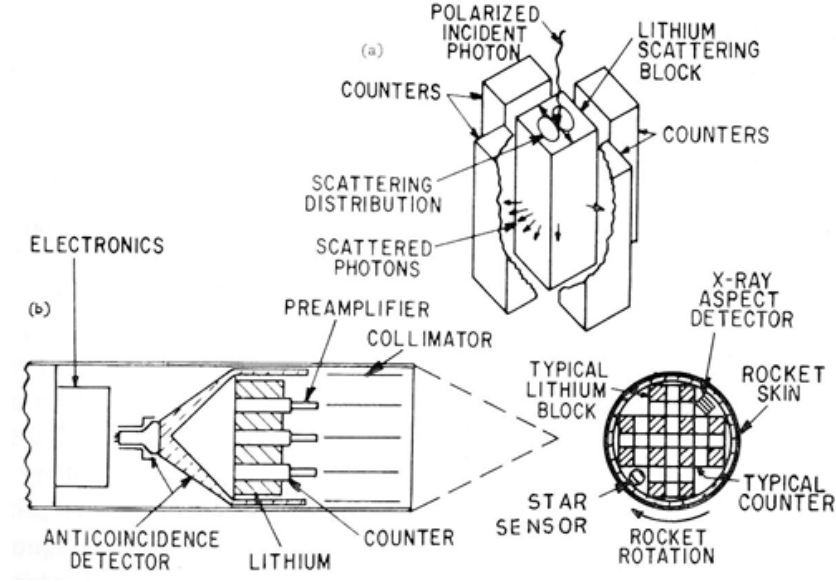
Figure 1. ( a ) A single polarimeter element consisting of a block of lithium surrounded by four proportional counters; ( b ) schematic of the rocket payload, side view; and ( c ) schematic of the rocket payload, front view.